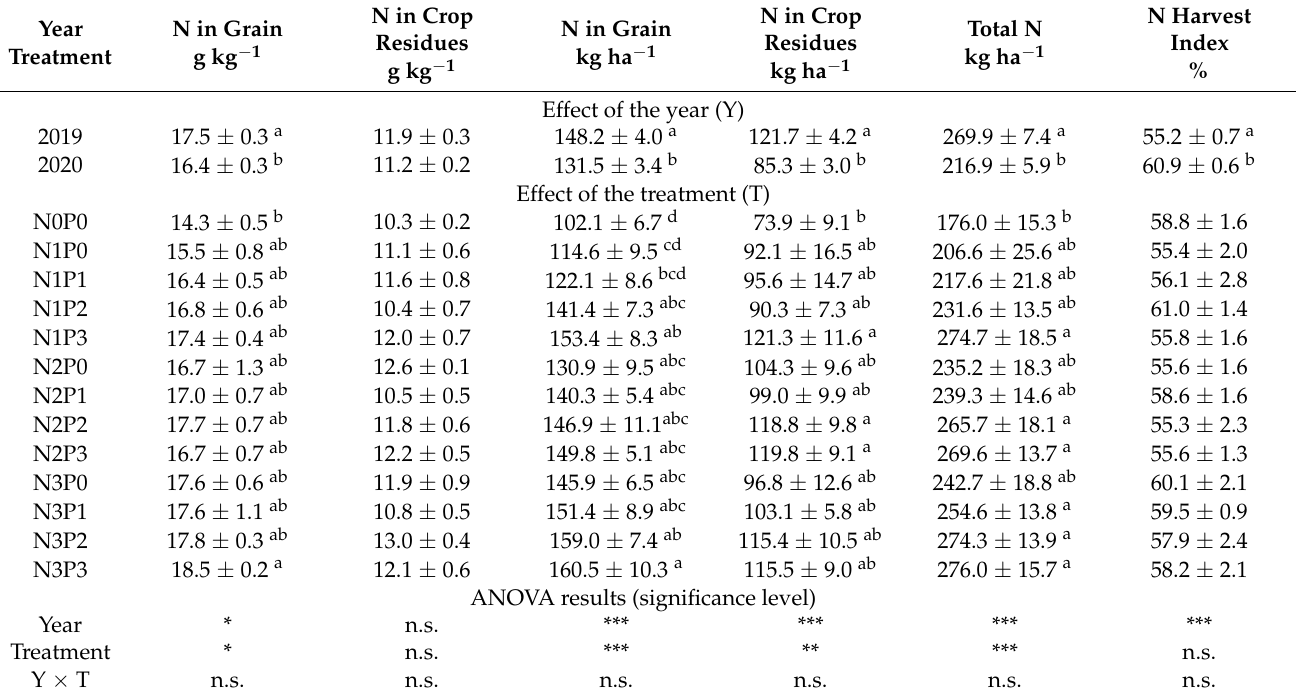
Table 1. Nitrogen (N) concentration and accumulation in maize at maturity (harvest) depending on fertilization